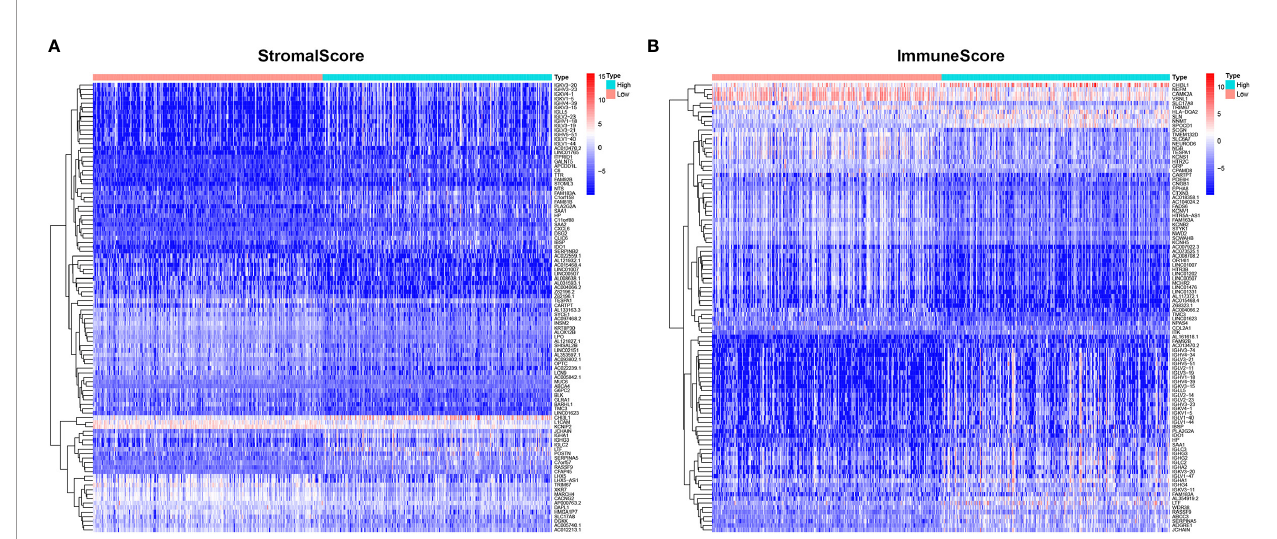
FIGURE 4 | Heatmaps, Venn plots for DEGs. (A) Heatmap for DEGs generated by comparison of the high score group vs. the low score group in ImmuneScore. Row name of heatmap is the gene name, and column name is the ID of samples which not shown in plot. Differentially expressed genes were determined by Wilcoxon rank sum test with q = 0.05 and fold-change > 1 after log2 transformation as the signi fi cance threshold. (B) Heatmap for DEGs in StromalScore, similar with (A) .